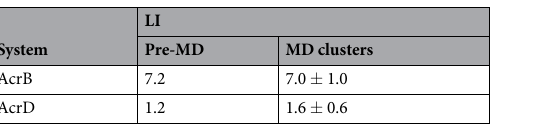
Table 3. Lipophilic indexes of AP in the Loose protomer of AcrB and AcrD. For AcrB, the pre-MD structure corresponds to the crystal structure identified by PDB code 4DX5 16 while for AcrD it is the final optimized homology model used as starting configuration for MD